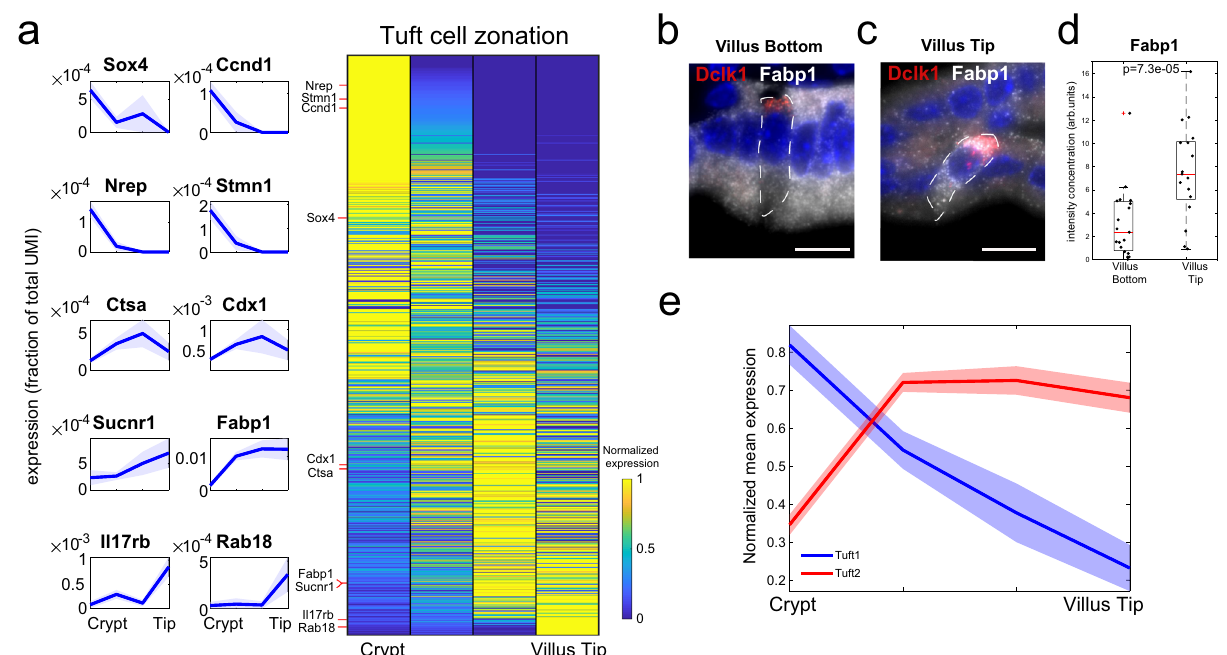
Fig. 4 Spatial reconstruction of tuft cells. a Reconstructed zonation pro fi les based on single tuft cells. Pro fi les are normalized to their maximum across zones. Plots on the left show zonation pro fi les of representative crypt (Sox4, Ccnd1, Nrep, Stmn1), mid-villus (Ctsa, Cdx1) and tip (Sucnr1, Fabp1, Il17rb, Rab18) genes. Light areas denote the SEM. b , c Representative smFISH images of the tuft zonated gene Fabp1 (gray) in a villus bottom ( b ) and a villus tip ( c ) tuft cell. Tuft cells were identi fi ed using Dclk1 (red). Scale bar 15 μ m. d Quanti fi cation of Fabp1 smFISH experiment. P value was calculated by Mann – Whitney U test two-sided. n = 20 cells were examined over 2 mice. Red lines are medians, black boxes are 25 – 75 percentiles. Whiskers extend to the most extreme data point within 1.5× the interquartile range (IQR) from the box. Source data are provided as a Source data fi le. e Mean max-normalized zonation pro fi les for tuft1 and tuft2 genes. Light areas denote the